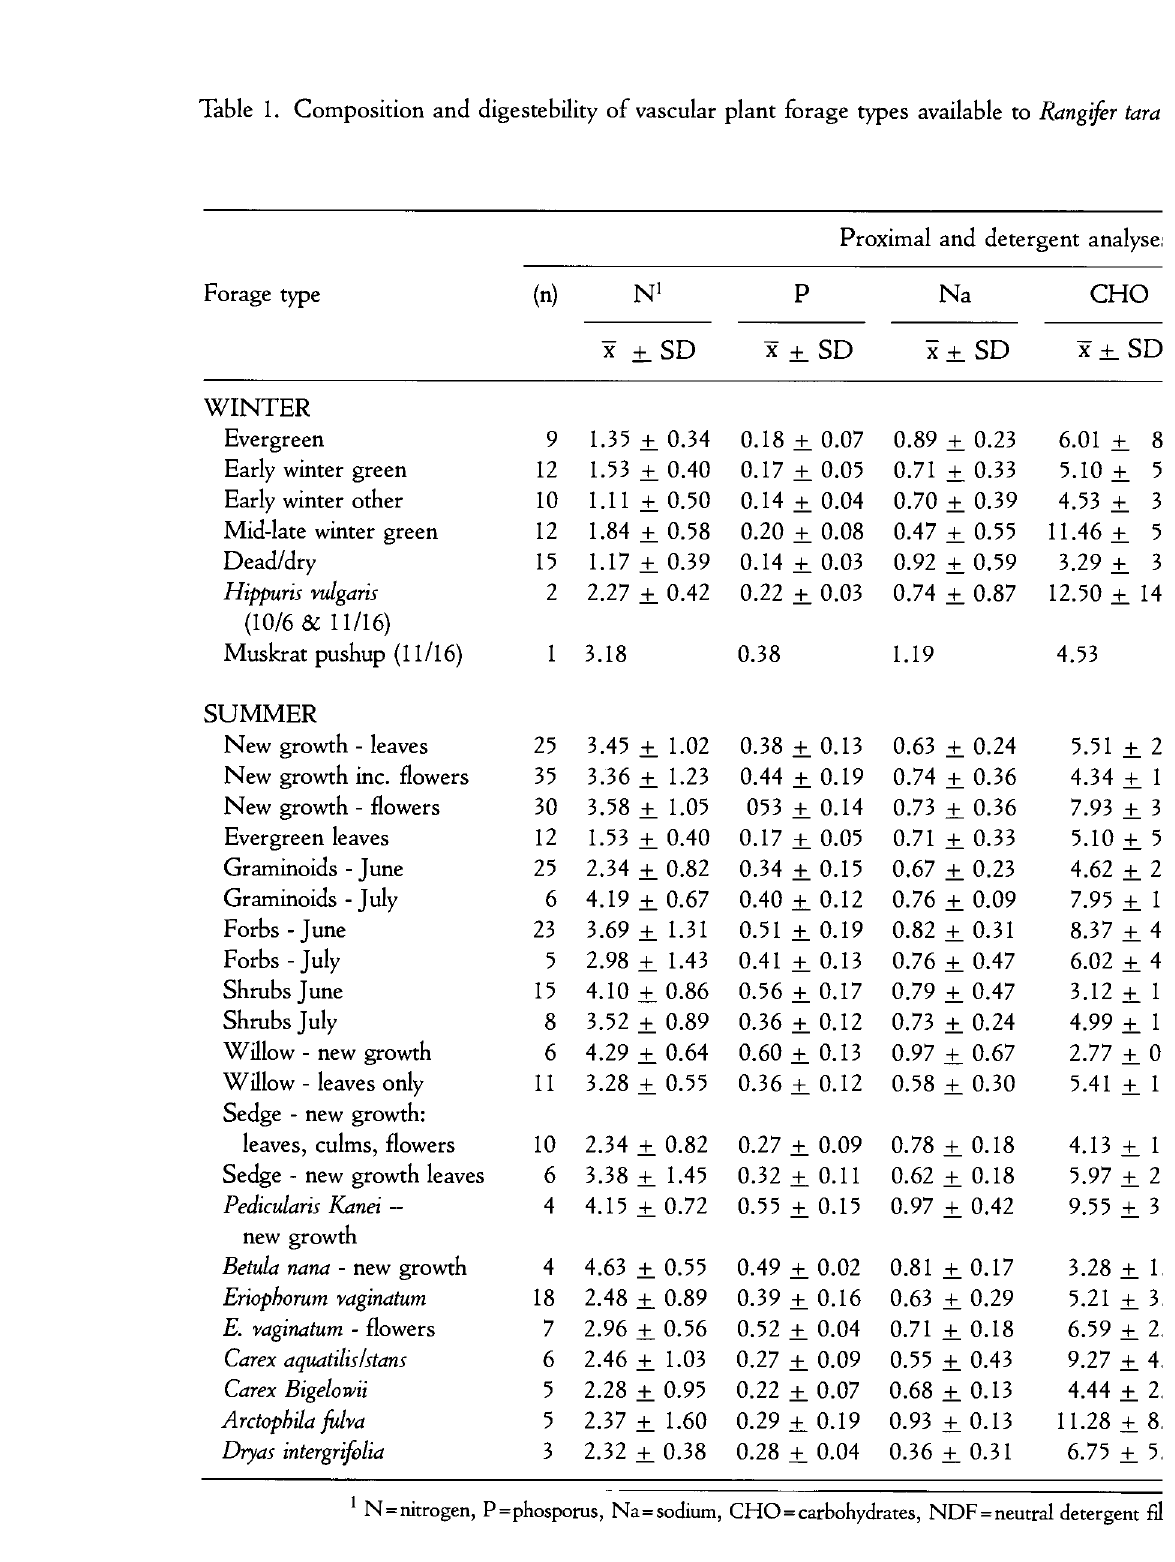
Table 1. Composition and digestebility of vascular plant forage types available to Rangifer tara,